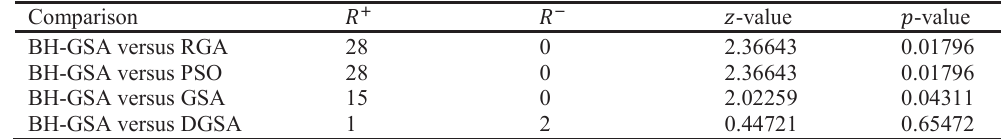
Table 7. Wilcoxon signed ranks test results for unimodal test functions of set 1.